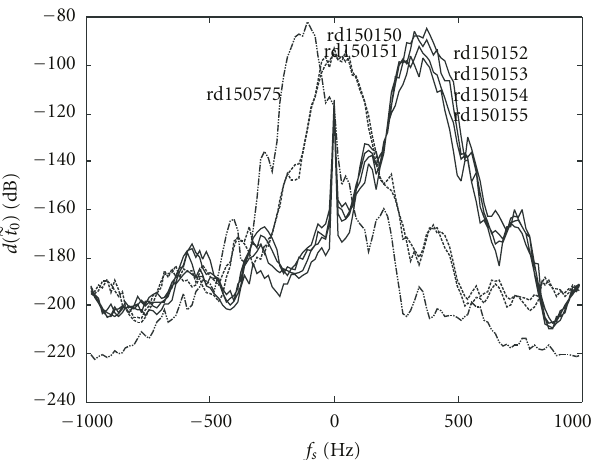
Figure 8: Plot of the optimal value of d ( (cid:10) t 0 ) for every guessed value of f s